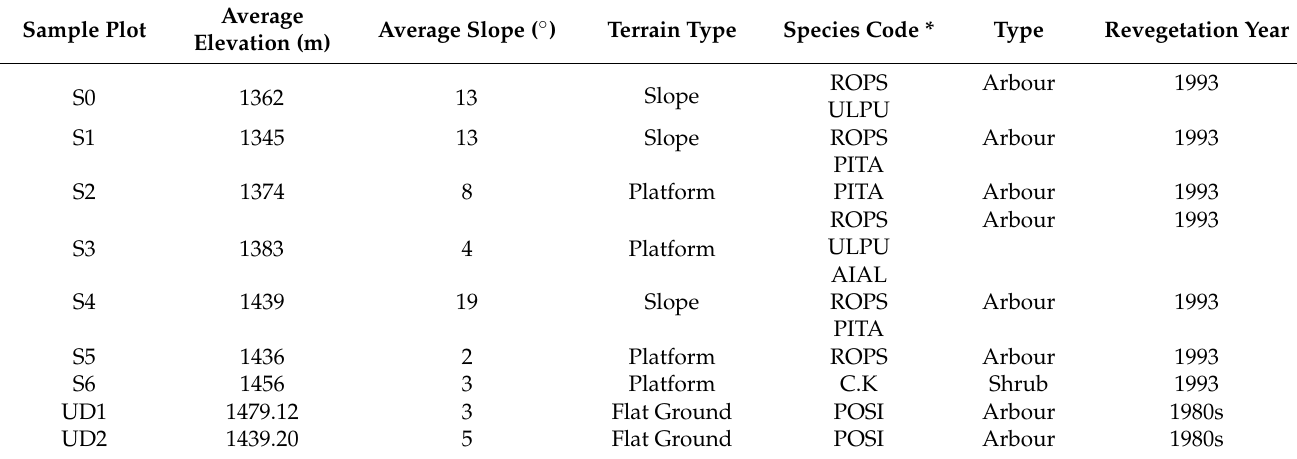
Table 1. Detailed information for sample